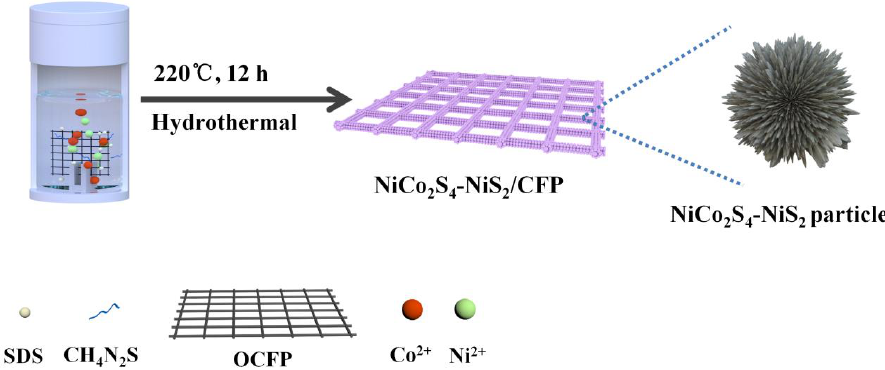
Figure 1. Schematic diagram showing the process for synthesizing NiCo 2 S 4 -NiS 2 /CFP.